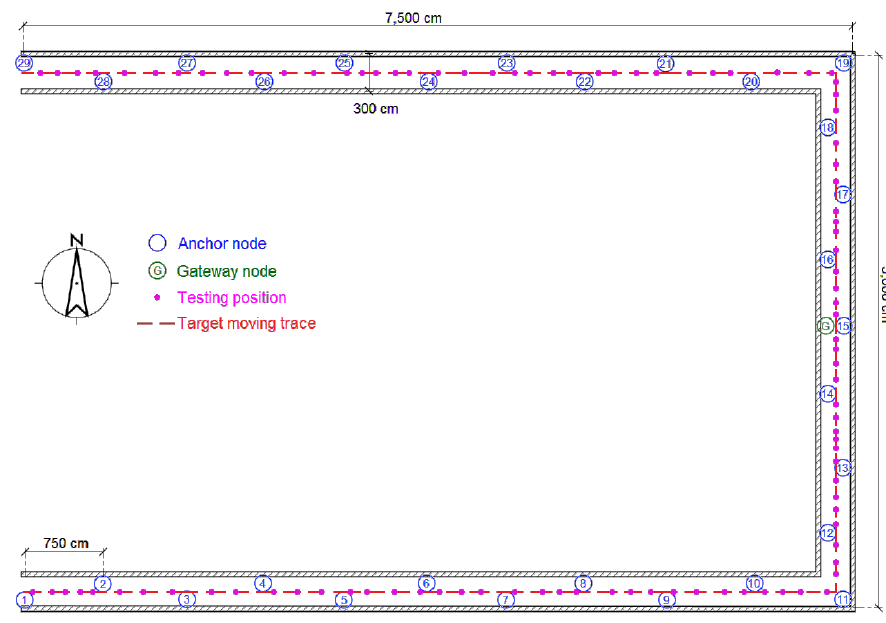
Figure 14. Map and nodes’ deployment for testing scenario 1.